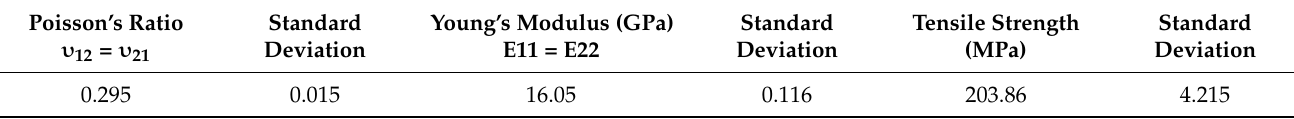
Table 2. The mechanical properties of woven GFRP composites.